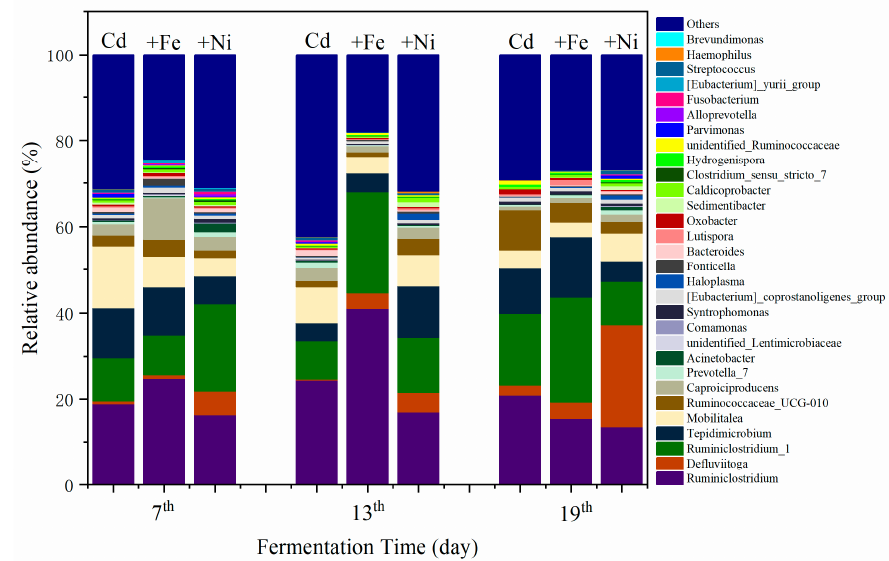
Figure 6. Impact of Cd, Cd + Fe, and Cd + Ni addition on the structure of bacterial communities during the fermentation.